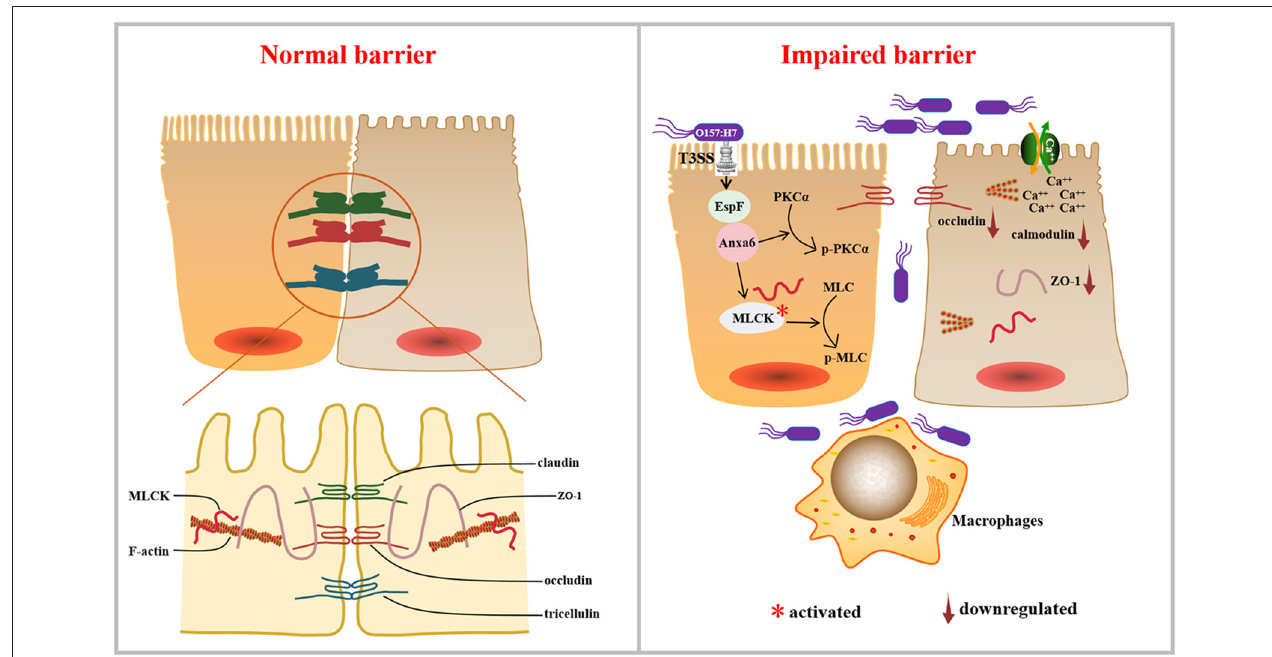
FIGURE 8 | Working model: the pathogen EHEC disrupts TJs during infection, which depends on its effector protein EspF. EspF interacts with host protein ANXA6, depletes the expression levels of ZO-1 and occludin, disrupts the distribution of ZO-1, activates MLCK, induces the phosphorylation of MLC and PKC α , and decreases the expression of Calmodulin, which results in the dysregulation of the